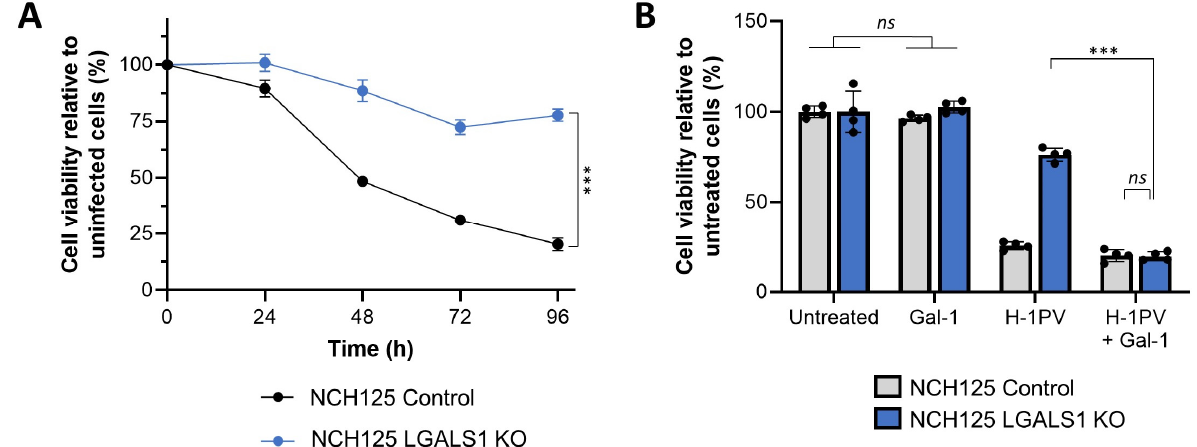
Figure 4. H-1PV has reduced oncolytic activity in NCH125 LGALS1 KO cells, which is rescued by supplementing with recombinant Gal-1 protein; ( A ) H-1PV oncolytic activity is reduced in NCH125 LGALS1 KO cells. Control and LGASL1 KO cells were infected with H-1PV at an MOI of 1 pfu/cell. Cell viability was assessed by MTT every 24 h for a total of 96 h. The curve plot depicts the mean ± standard deviation for each time point expressed as a percentage of cell viability compared to corresponding uninfected cells. The independent experiment shown was repeated thrice each with four biologically independent samples (*** p ≤ 0.001). ( B ) Purified Gal-1 rescues H-1PV oncolytic activity in NCH125 LGALS1 KO cells. Control and LGASL1 KO cells were infected (or not) with H-1PV at an MOI of 1 pfu/cell, in the presence or absence of 5 µ g/mL of human recombinant Gal-1. Cell viability was assessed at 72 h post-infection by MTT. Columns depict the percentage (mean value) of cell viability compared to uninfected cells ± standard deviation bars. The independent experiment shown was repeated twice each with four biologically independent samples ( ns: p > 0.05; *** p ≤ 0.001, calculated using a one-way